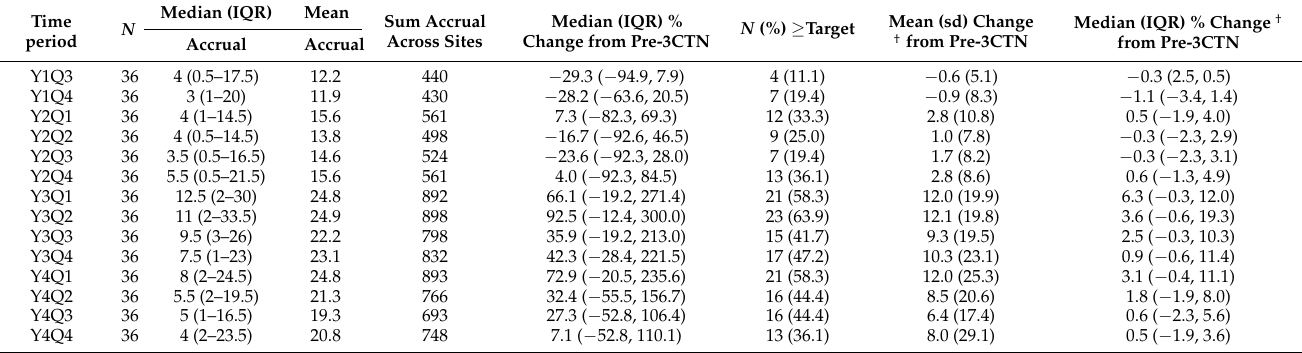
Table A1. Quarterly accrual at Network sites—subgroup of those N = 36 followed for entire time period.